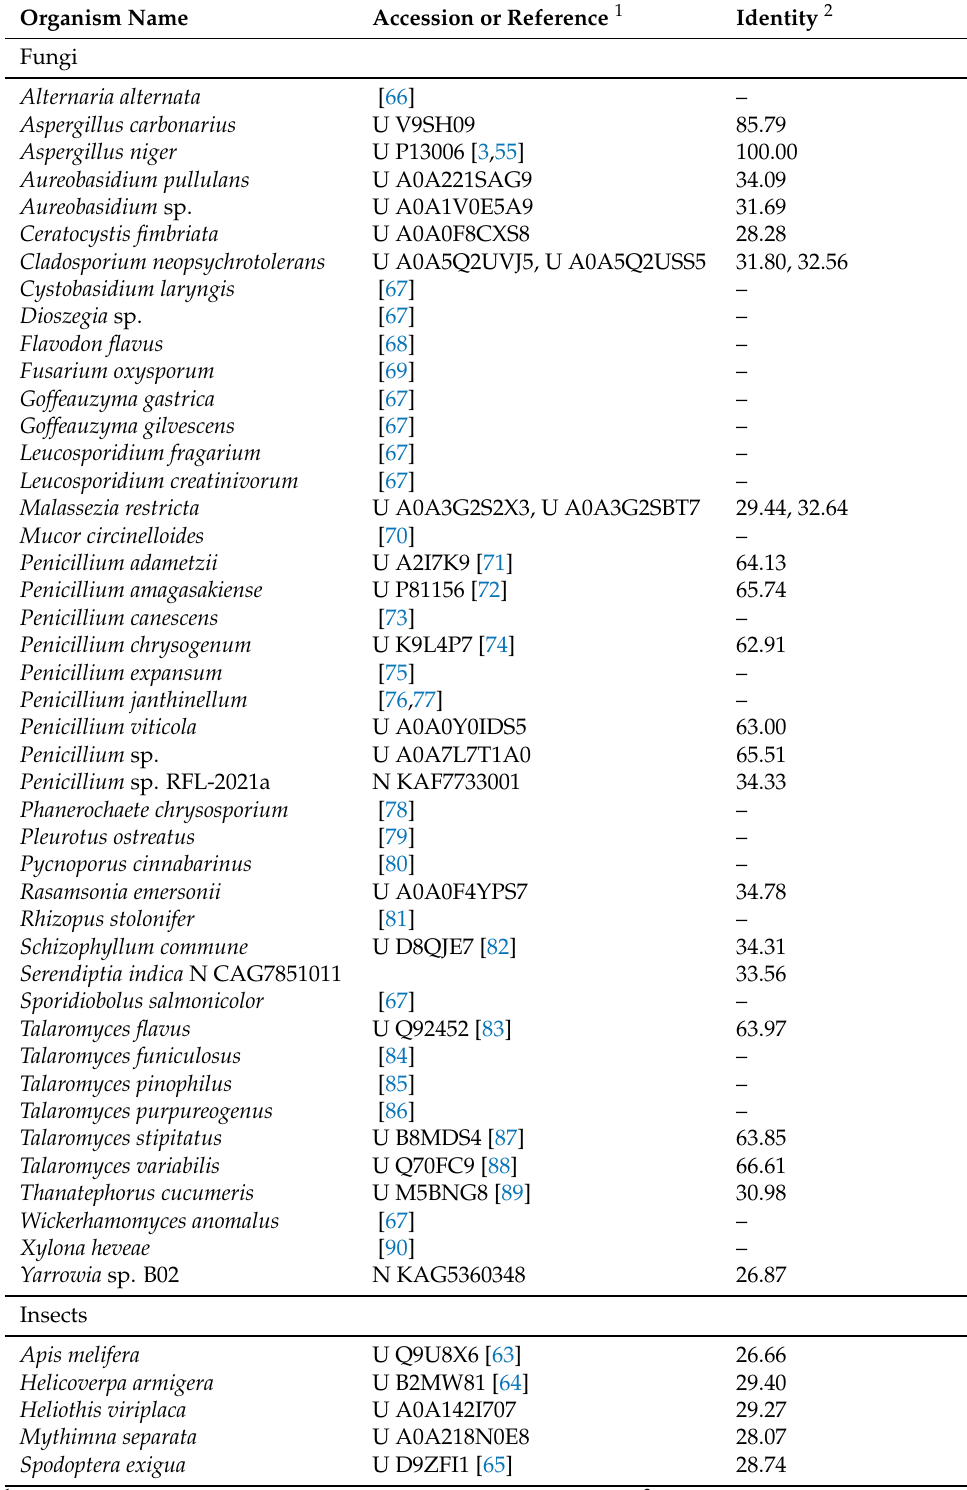
Table 4. GOx-producing organisms in at least one major database or at least one